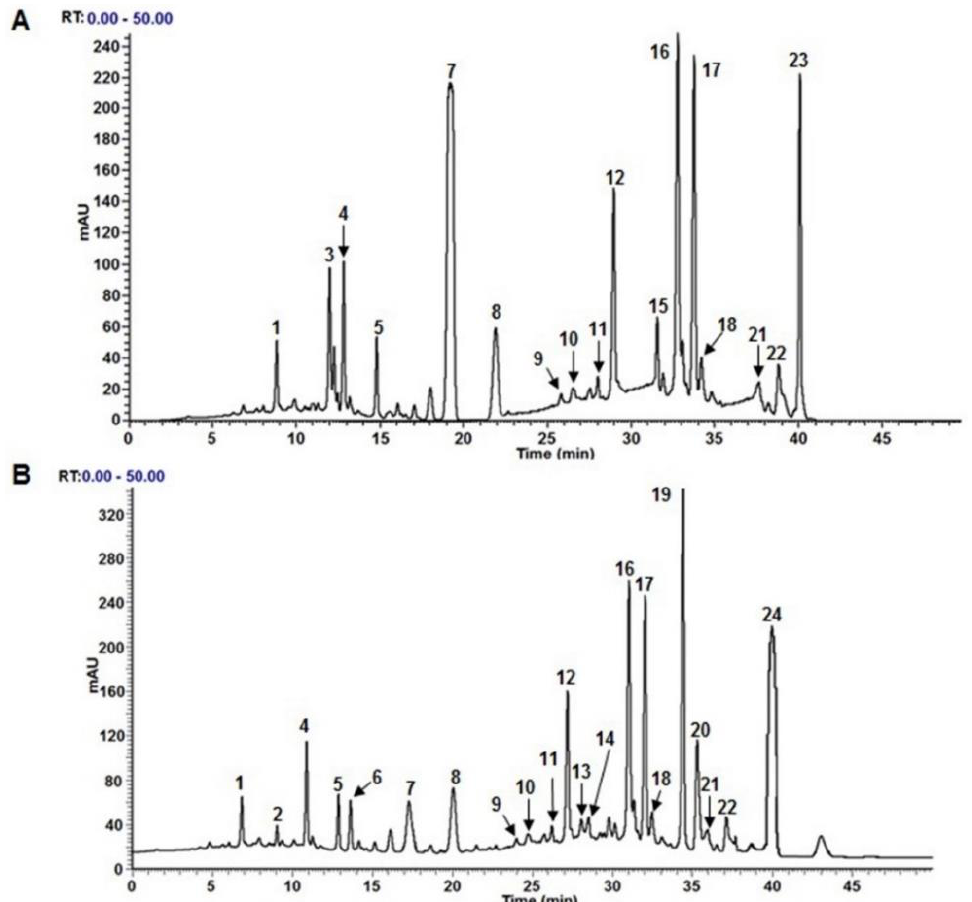
Figure 2. Chromatography separation of phytochemical compounds found in extracts of ( A ) unprocessed sesame seeds byproduct flour beverage −10% (UB10) and ( B ) extruded sesame seeds byproduct flour beverage-10 (EB10). 1: 3- O -p-Coumaroylquinic acid, 2: Vanillic acid, 3: Caffeic acid, 4: